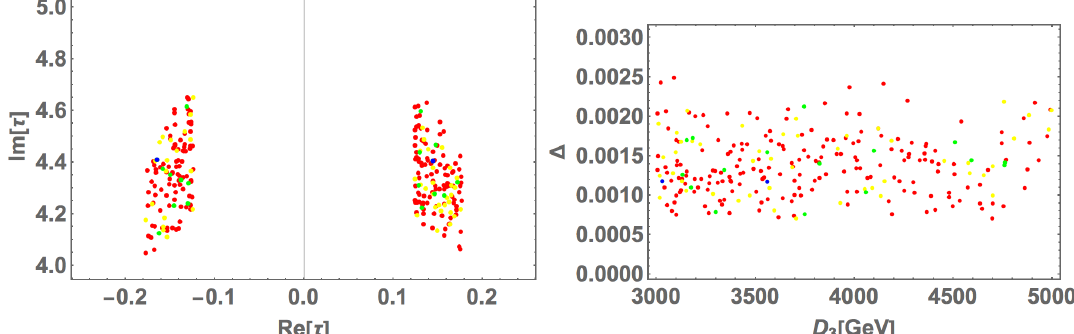
Figure 1 . The left plot shows allowed region of τ , while the right one shows the mass degeneracy of D 1 and D 2 that is defined by ∆ ≡ ( D 2 − D 1 ) /D 2 in terms of D 3 in GeV unit, where D 2 ( ∼ D 1 ) ∼ D 3 / 2 . Each point in blue, green, yellow, and red color represents the allowed region in σ ≤ 1 , 1 < σ ≤ 2 , 2 < σ ≤ 3 , and 3 < σ ≤ 5 interval,